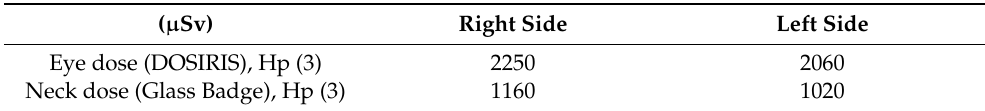
Table 2. Total physician doses (eye and neck) received in 18 months during CTF procedures (95 procedures).